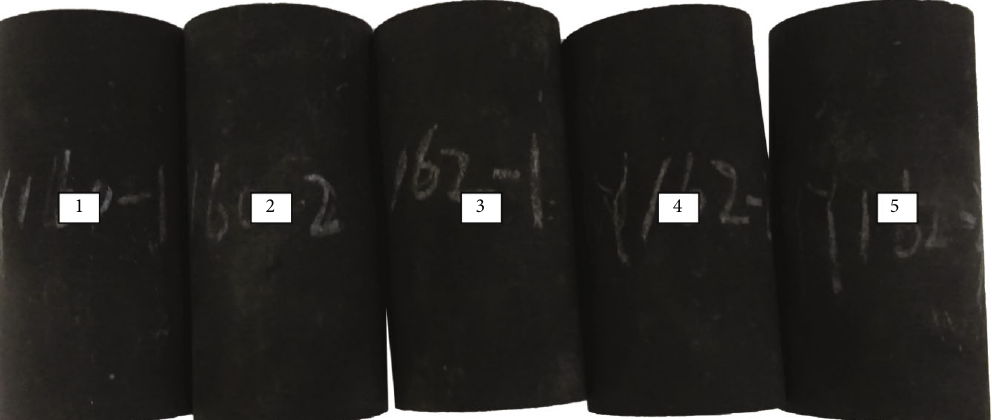
Figure 5: Five shale test samples.